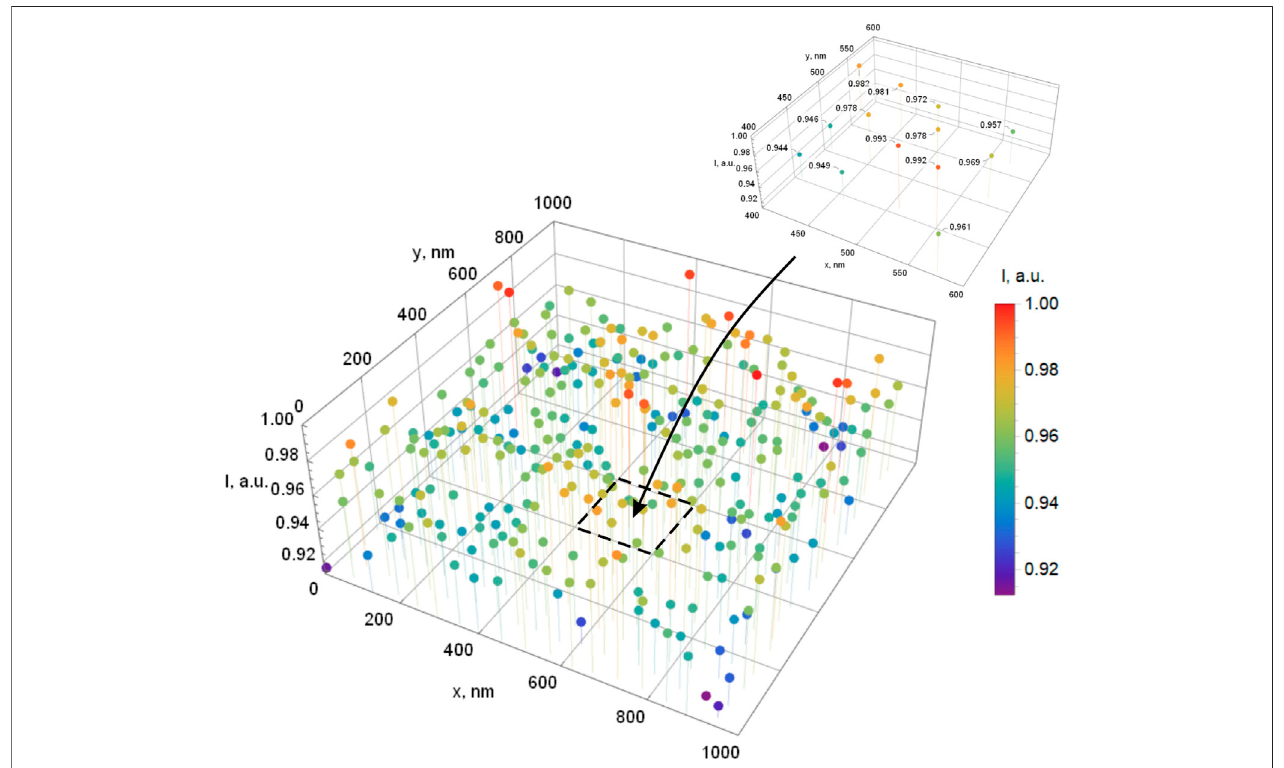
FIGURE 6 | Diagram illustrating the luminescence intensity of the carbon nanoparticle in different points of the surface region shown in Figure 1 . Inset: magni fi ed area 0.2 × 0.2 μ m 2 , relative luminescence response is indicated near each point.